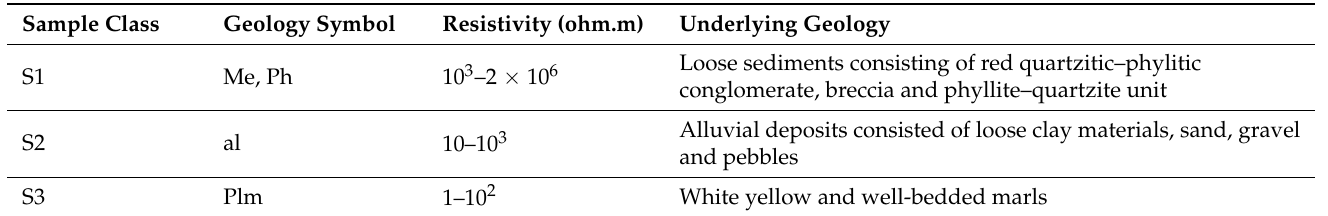
Table 1. Sample classification according to surface geological structure. Geology symbols drawn from Figure 2. Ranges of resistivity values based on